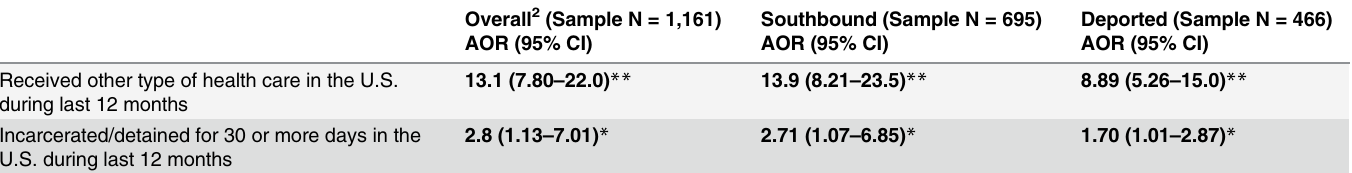
Table 2. Association between receipt of health care services and incarceration or detention with the likelihood of reporting last 12-months HIV testing among circular Mexican migrants returning from the U.S. via Tijuana, Mexico 1